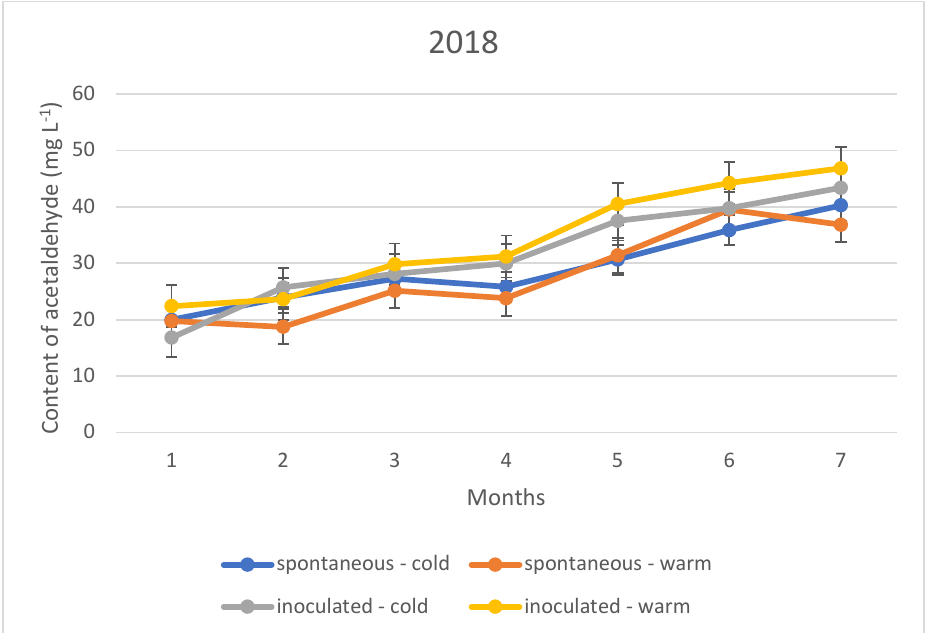
Figure 4. Acetaldehyde content of the wines tested during storage in 2017.